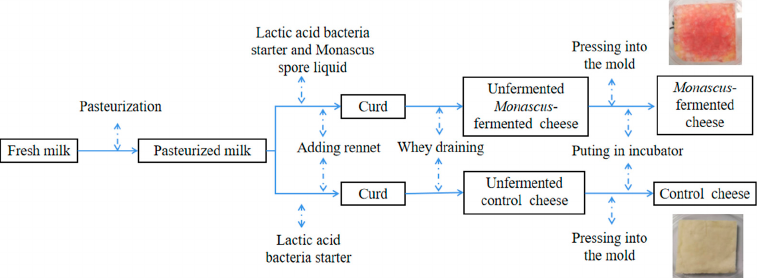
Figure 1. The process of making the Monascus -fermented cheese and the control cheese.